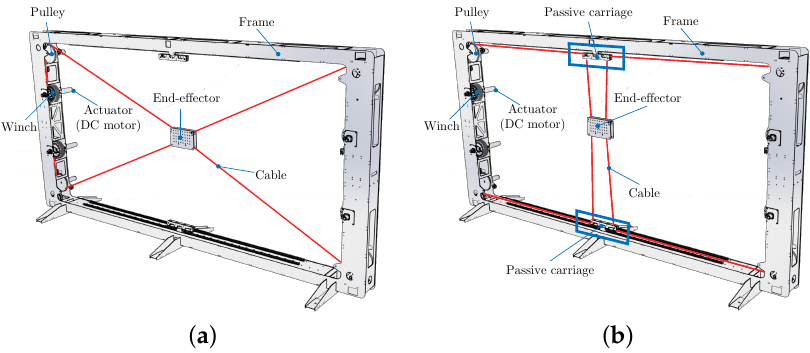
Figure 1. Scheme comparison. ( a ) Conventional scheme; ( b ) new proposal.